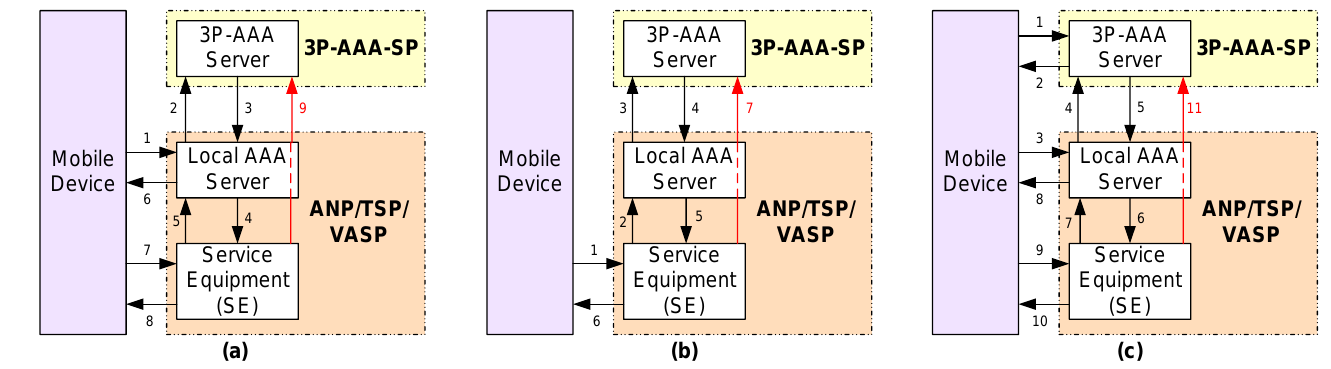
Figure 3. The signaling and message-exchange sequences across relevant inter-domain interfaces for three different authorization models [19] for the 3P-AAA provision: ( a ) agent model, ( b ) pull model, and ( c ) push